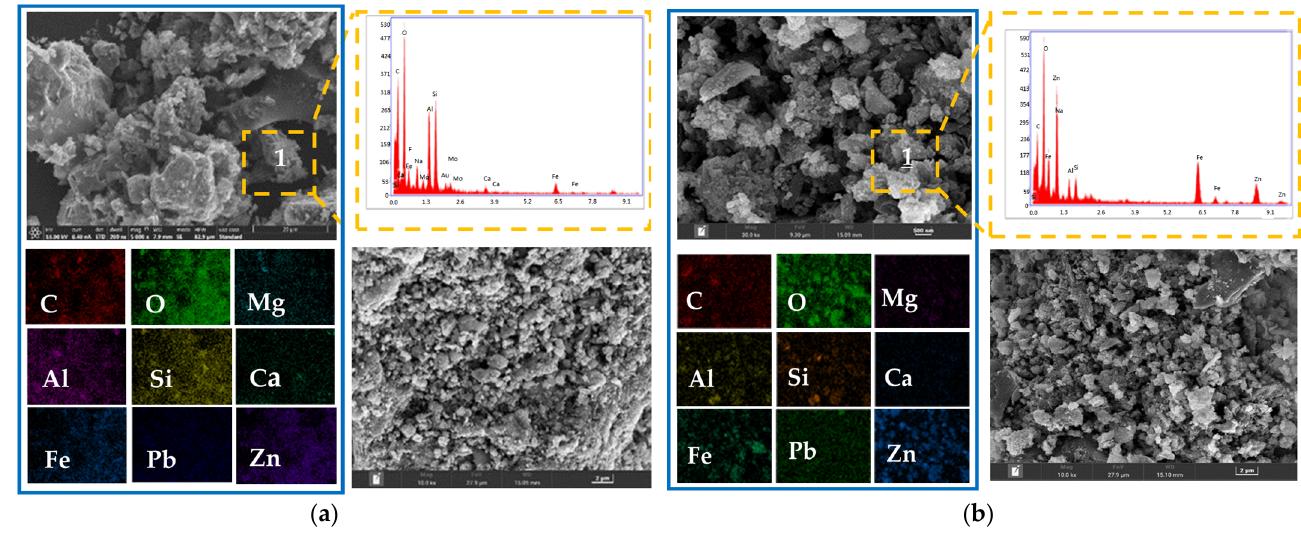
Figure 15. SEM morphologies and EDS pattern of leaching residue ( a ) conventional: temperature = 60 ℃ , liquid ‐ solid ratio =12:1, stirring speed = 400 rpm, time = 120 min, “1” in ( a ) means: time = 240 min. ( b ) ultrasonic: temperature = 60 ℃ , liquid ‐ solid ratio = 12:1, ultrasonic power = 450 W, time = 120 min, “1” in ( b ) means: time = 240 min.